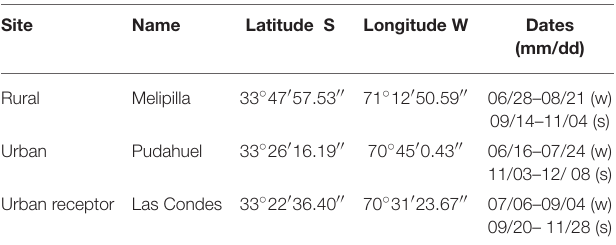
TABLE 1 | Description of the field campaign sites where the measurements were conducted during winter (w) and spring (s) of